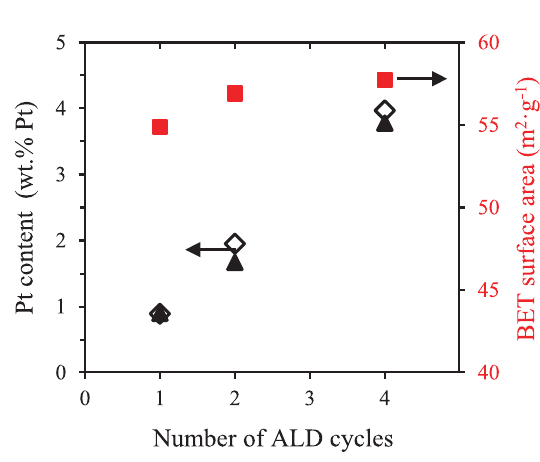
Fig. 9 Pt content measured by ICP ( ▲ ) and predicted loading value for ideal ALD ( ◇ ) along with specific surface area ( ■ ) for 1–4 ALD cycles (Pt content values cor- rected for changes in surface area after